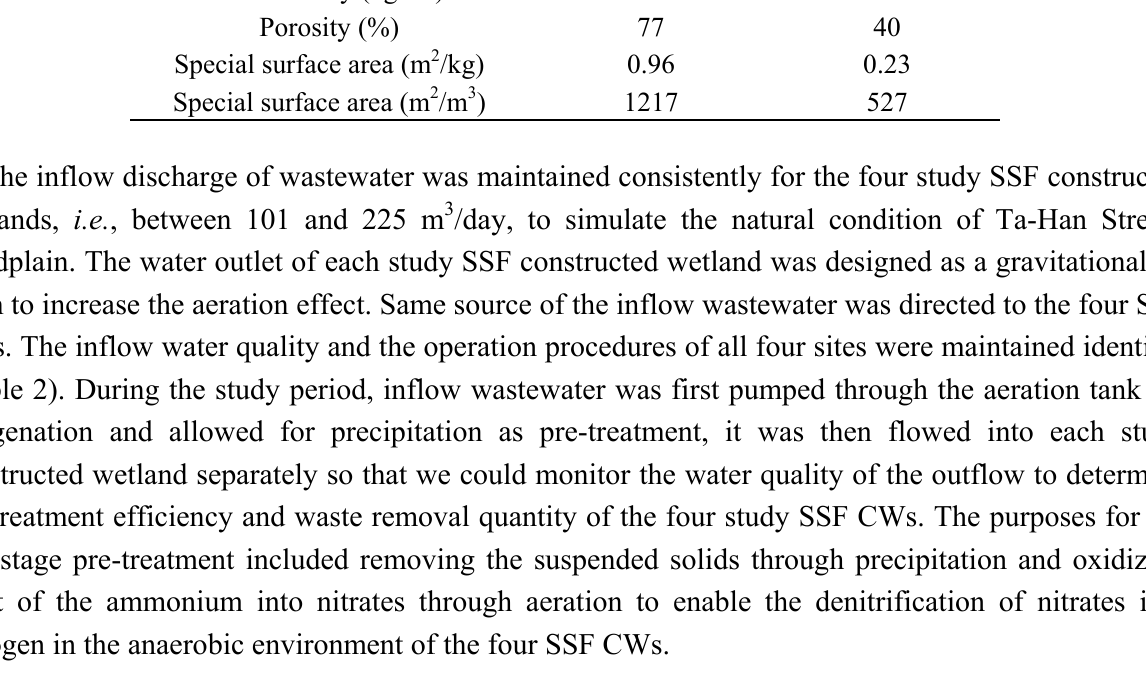
Table 2. Water quality parameters of the wetland influent in this